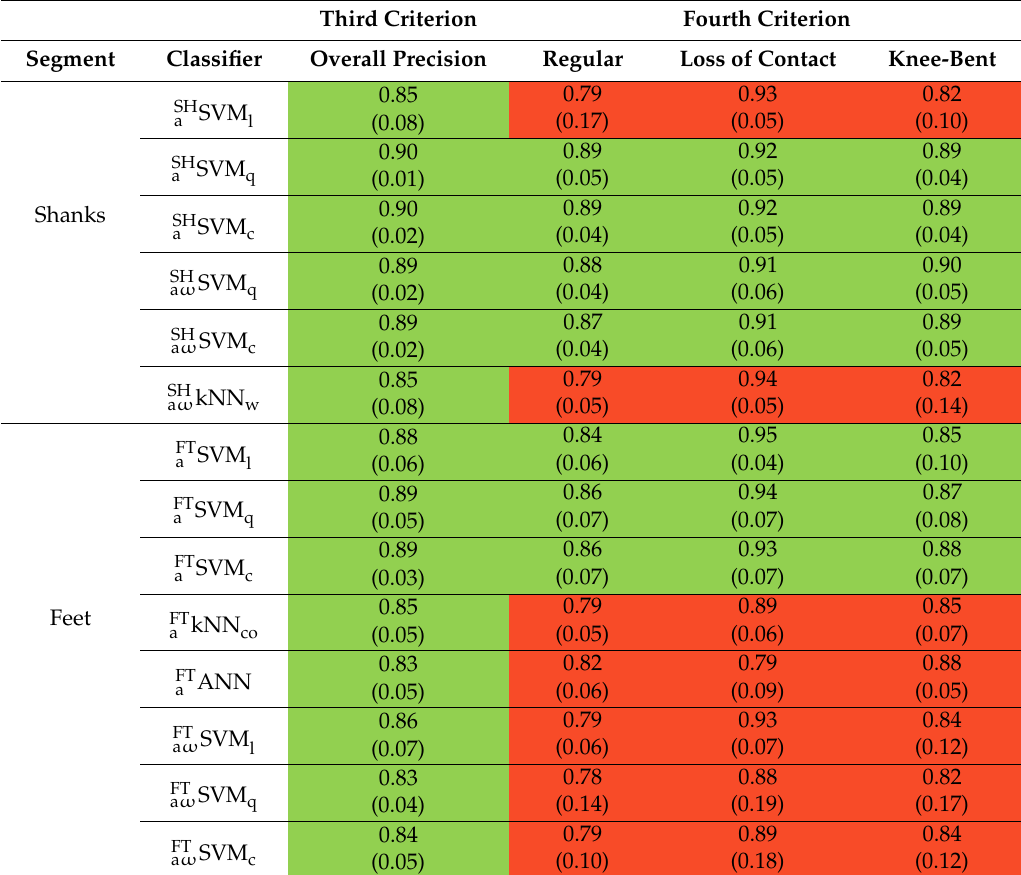
Table 5. Mean and standard deviation of the overall precision and the precision for each condition. The green cells represent classifiers that passed the third and fourth selection criteria; the others are highlighted in